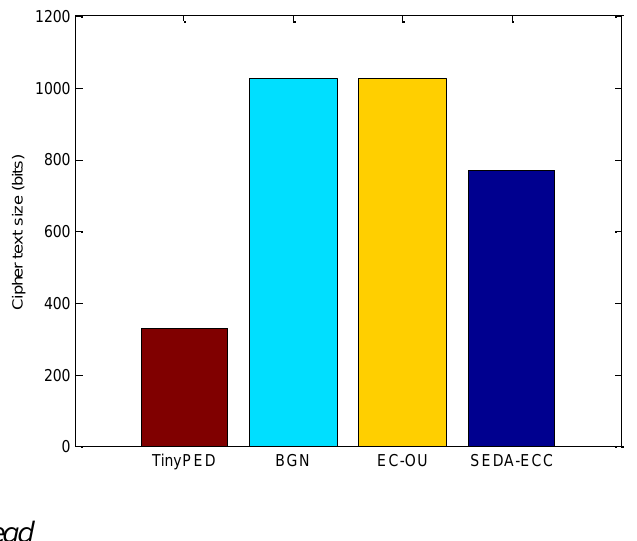
Figure 6. The comparison of ciphertext